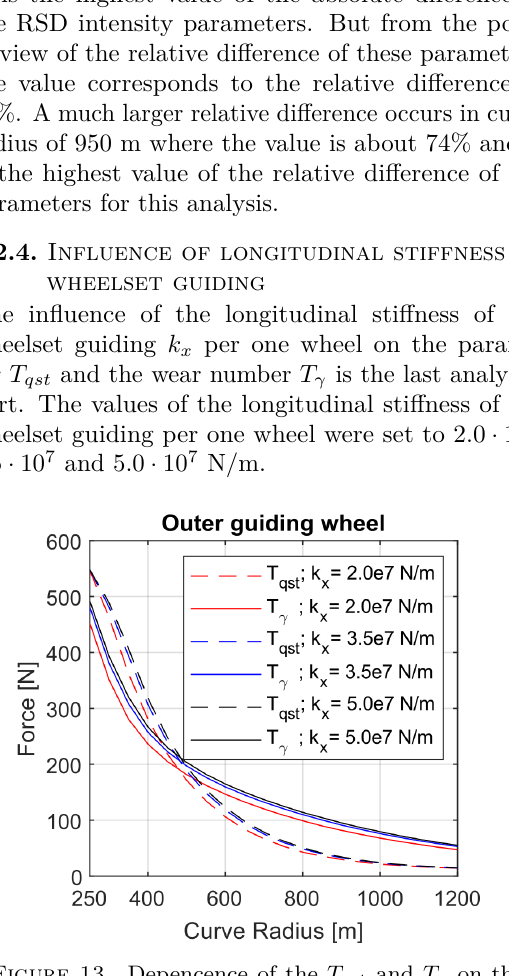
Figure 13. Depencence of the T qst and T γ on the curve radius R in defined range of the longitudinal stiffness of wheelset guiding k x per one wheel.